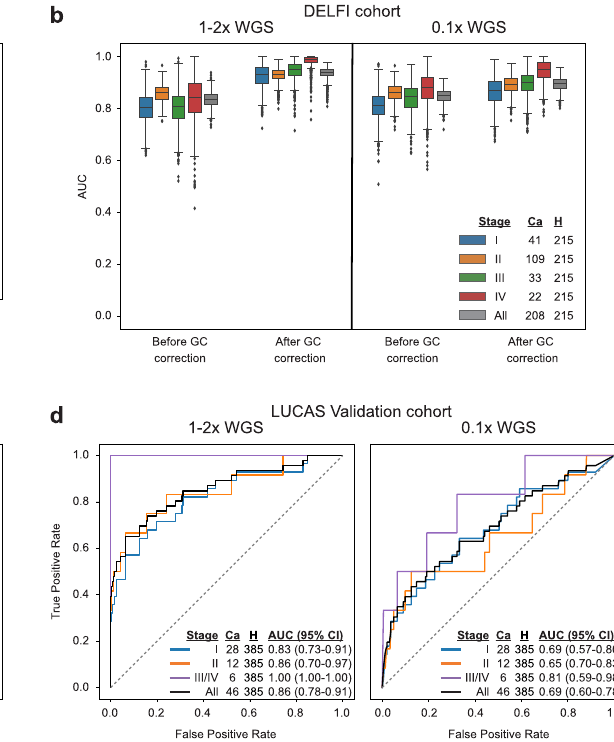
Fig. 3 | Grif fi n enables accurate cancer detection. Receiver operator character- istic(ROC)curvesforlogisticregressionclassi fi cationofcancervs.healthycontrols in three cohorts. Logistic regression was performed on the top PCA components which explained 80% of the variance in the features (central coverage, mean cov- erage, and amplitude) extracted from nucleosome pro fi les around 30,000 TFBSs for each of 270 TFs. ROC and area under the ROC curve (AUC) performance is shown for each disease stage. The number of cancer samples (Ca) is indicated for each stage. Each ROCcurve also includesall healthycontrols (H) from thatcohort. 95% con fi dence intervals (CI) were obtained from 1000 bootstrap iterations. a Performancefor DELFIcohort 38 consisting ofplasma samples for208 early-stage